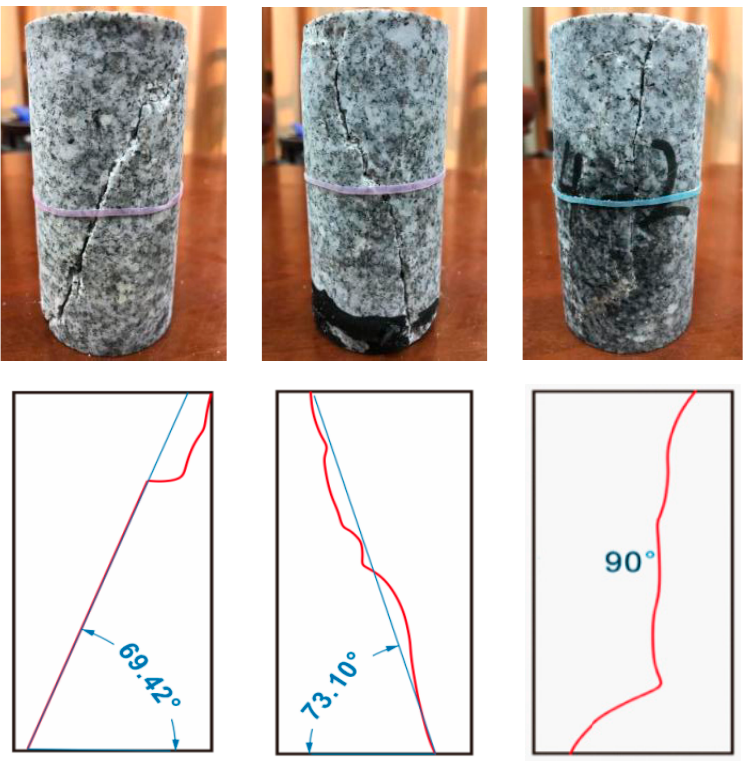
Figure 10. Test results and failure modes of granite with confining pressure at 5 MPa.